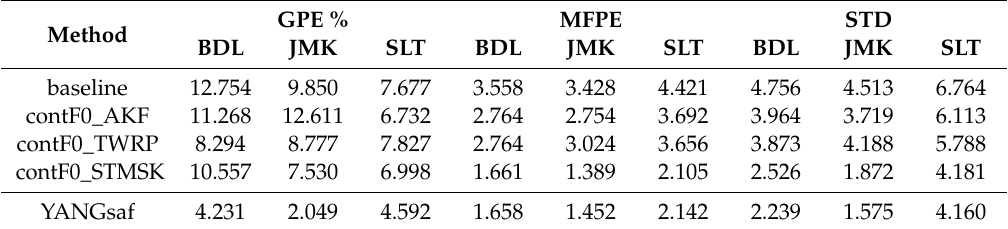
Table 1. Average scores performance per each speaker in clean